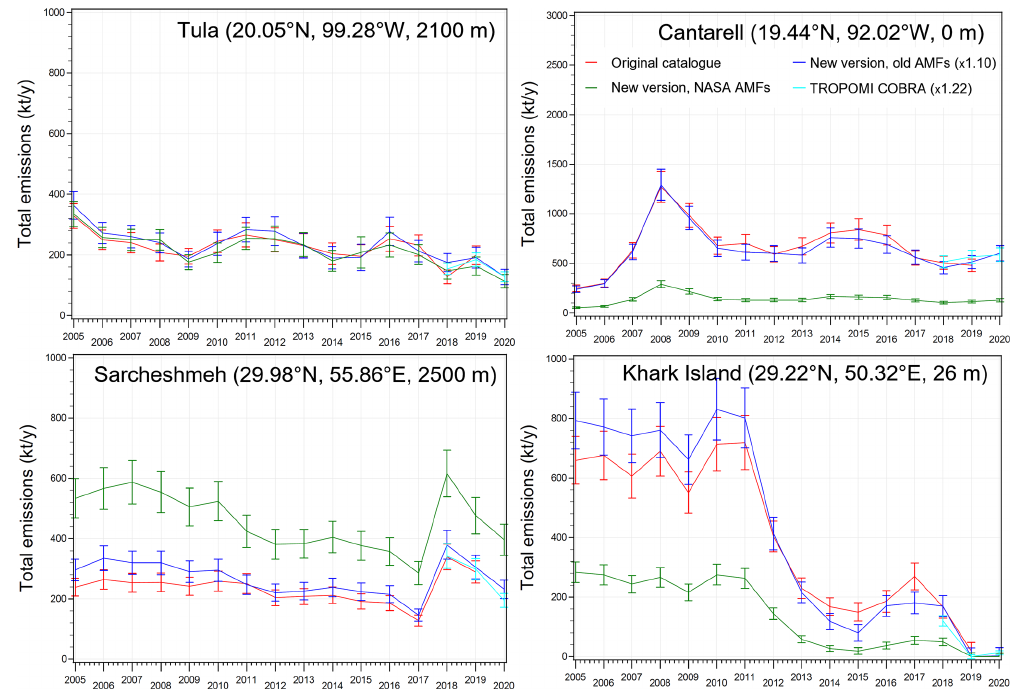
Figure 1. Four examples of SO 2 emission estimates with 2 σ error bars from the original catalogue (red), emissions estimated from OMI version 2 SCD values and converted to VCDs using the same AMFs as in the original catalogue (blue), and emissions estimated using version 2 OMI VCD data (green). We also included TROPOMI-based estimates (cyan). The emission source names, coordinates, and elevations above sea level are shown. TROPOMI-based estimates were increased by 22% and OMI and OMPS data were increased by 10% as discussed in the